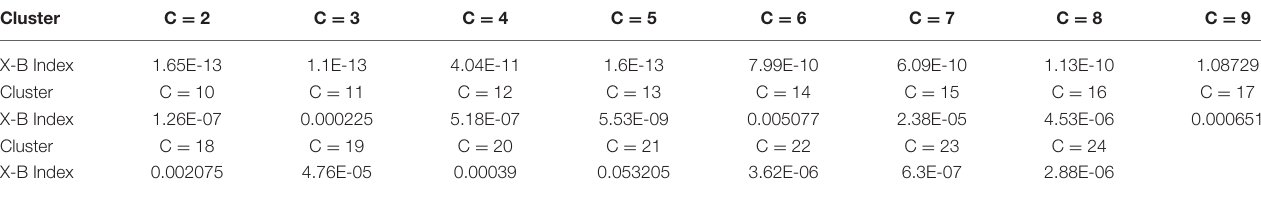
TABLE 1 | Xie-Beni Index for Fuzzy Cluster